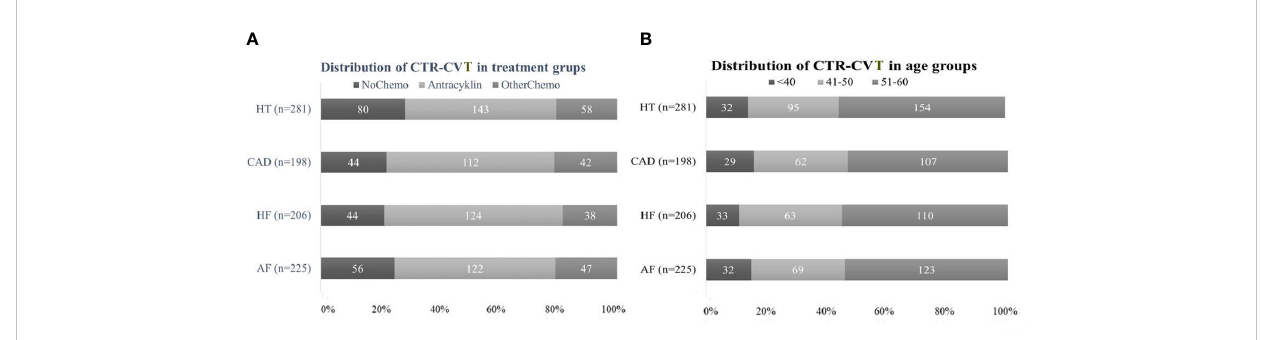
FIGURE 4 Distribution of 910 cancer therapy-related cardiovascular toxicity (CTR-CVT) events including hypertension (HT), coronary artery disease (CAD), heart failure (HF), and atrial fi brillation (AF) in 31 patients with lymph node-positive early breast cancer (BC) at diagnosis in the Southeast Healthcare Region, Sweden, January 1, 1998, to December 31, 2002. (A) (Left panel): Distribution of four CTR-CVT events by treatment group. Distribution of 910 CTR-CVT events in the anthracycline group 501 (55%), the other Chemo group 185 (20%), and the no Chemo 224 (25%). (B) (Right panel):